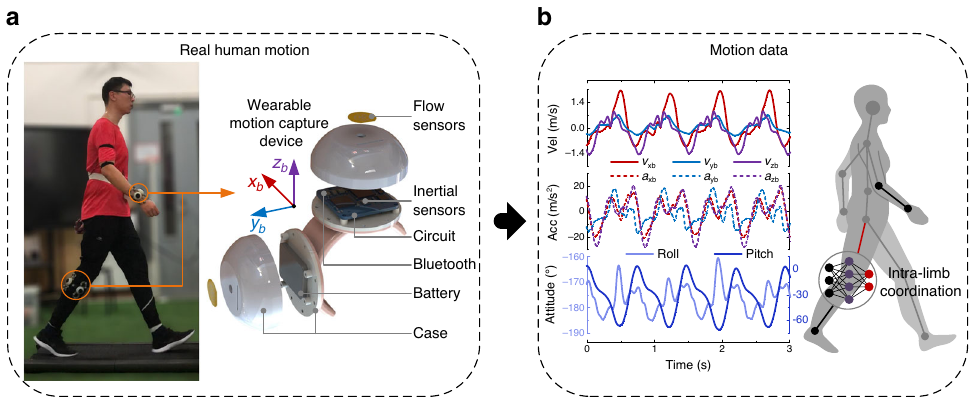
Fig. 1 Design of the motion capture scheme. a Our wearable device is worn on human body segments of interest for motion capture by incorporating tri- axis fl ow sensors with tri-axis inertial sensors. b Motion data including three-dimensional motion velocity, motion acceleration, and attitude angles can be measured by our device. The motion velocity and motion acceleration are measured via integral-free approach by using micro fl ow sensor which avoids accumulative errors. The attitude angles are then accurately determined by incorporating the motion velocity and acceleration detected by the fl ow sensor with inertial quantities detected by the inertial sensors. Therefore, drift and instability problems are overcome. A neural network model is established to characterize the natural intra-limb coordination for human lower limb and used to determine the thigh motion from the shank motion in human walking and running.